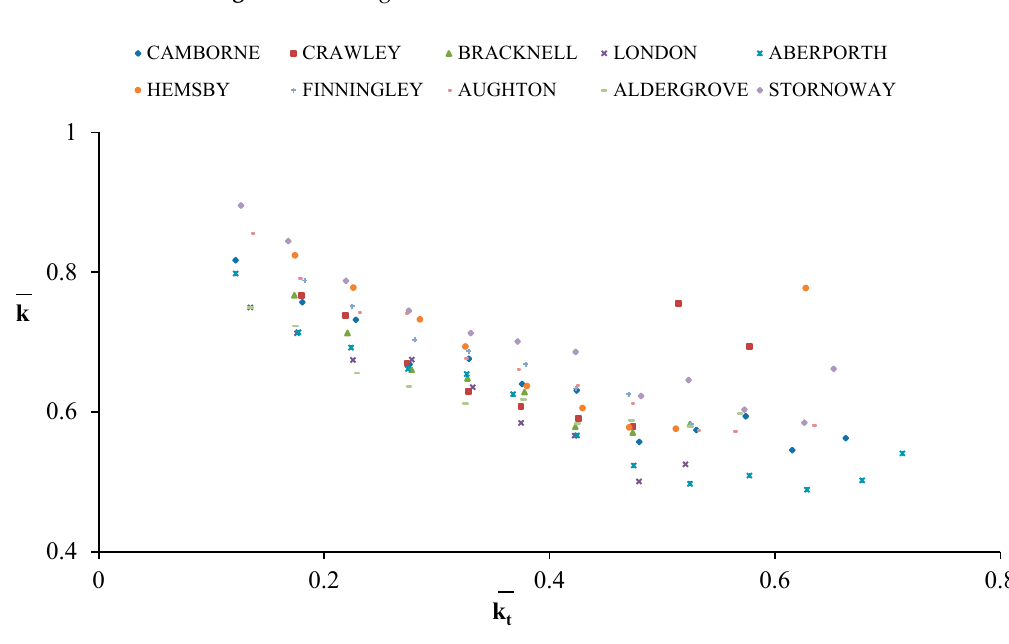
Figure 11. Average values of the k for cities in the 50°–58° N.